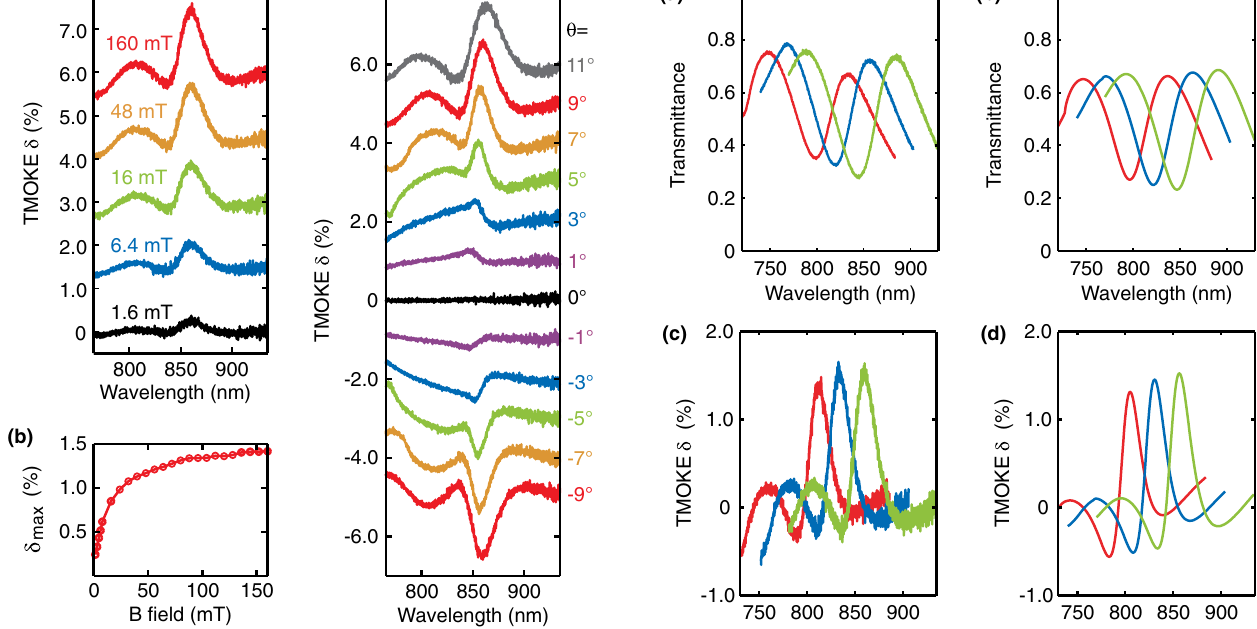
FIG. 3. (a) Measured and (b) simulated transmittance for the structures of a 450-nm period (red lines), a 475-nm period (blue lines), and a 500-nm period (green line). (c) Measured and (d) simulated TMOKE for the structures of a 450-nm period (red lines), a 475-nm period (blue lines), and a 500-nm period (green lines). Illumination is TM polarized with a 9 (cid:2) incident angle. An external magnetic field of 160 mT is